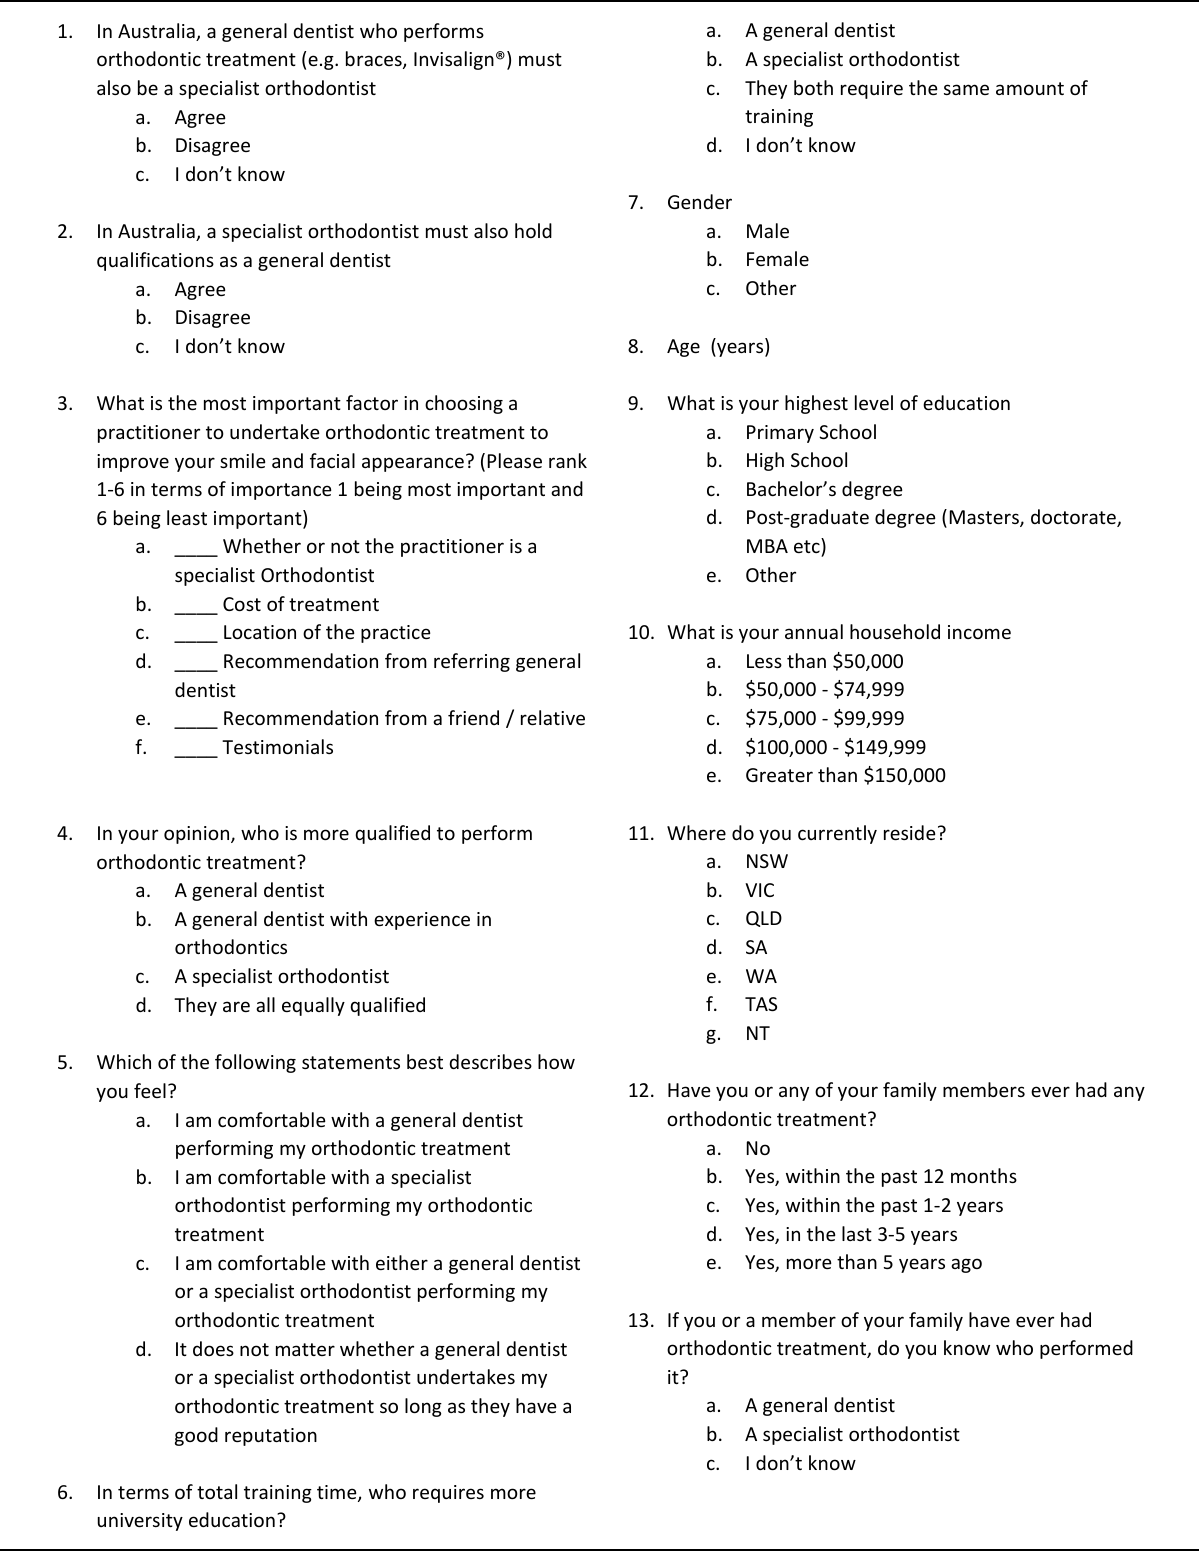
Figure 1. Survey used in the present